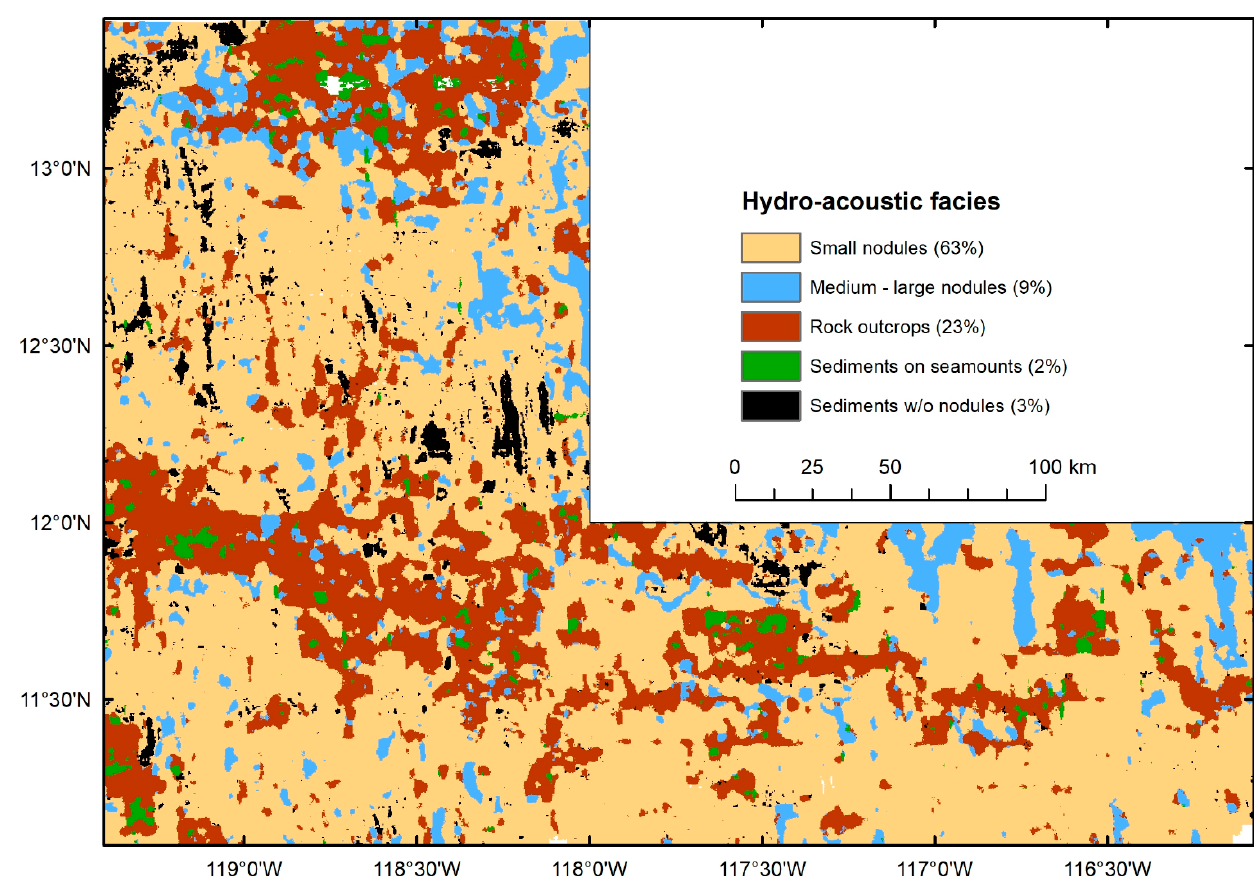
Figure 8. Distribution of five hydro-acoustic classes in Area E1 derived from backscatter analysis. Rock outcrops (class 4) and sediments on seamounts (class 5) are considered as one class (see text above).